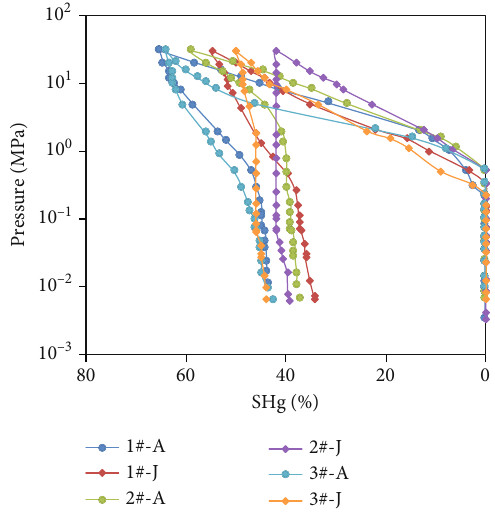
Figure 2: The mercury injection curves of vitrain and